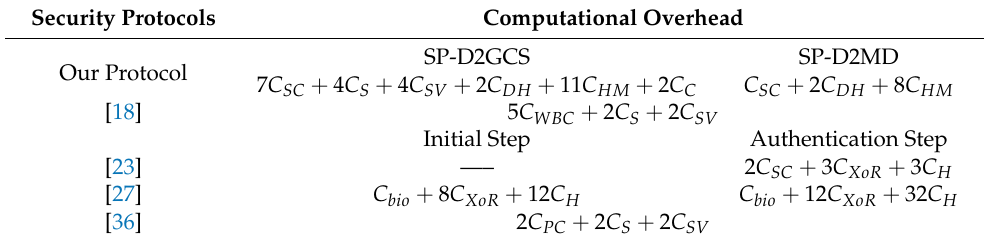
Table 6. Computational overhead